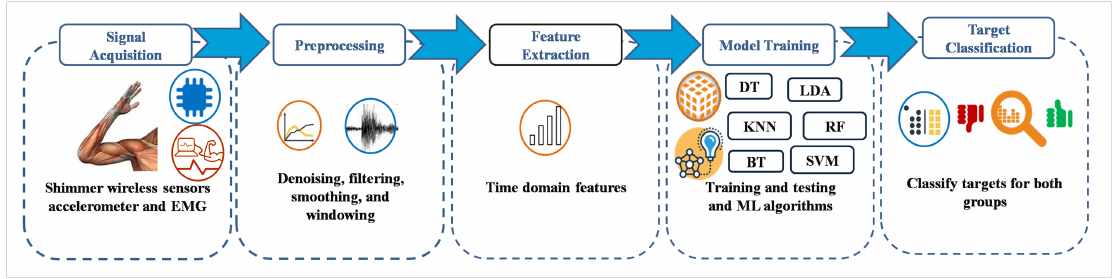
Figure 2. Architecture of the proposed